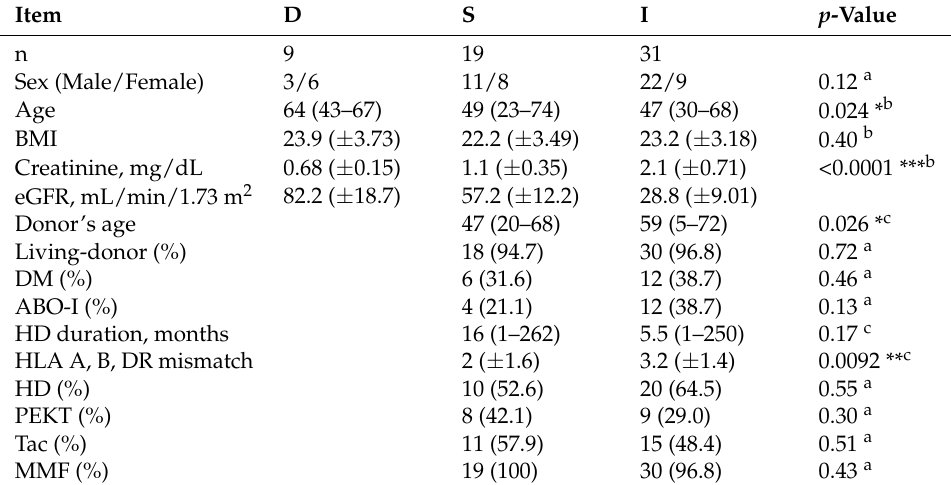
Table 1. Characteristics of all participants in the three